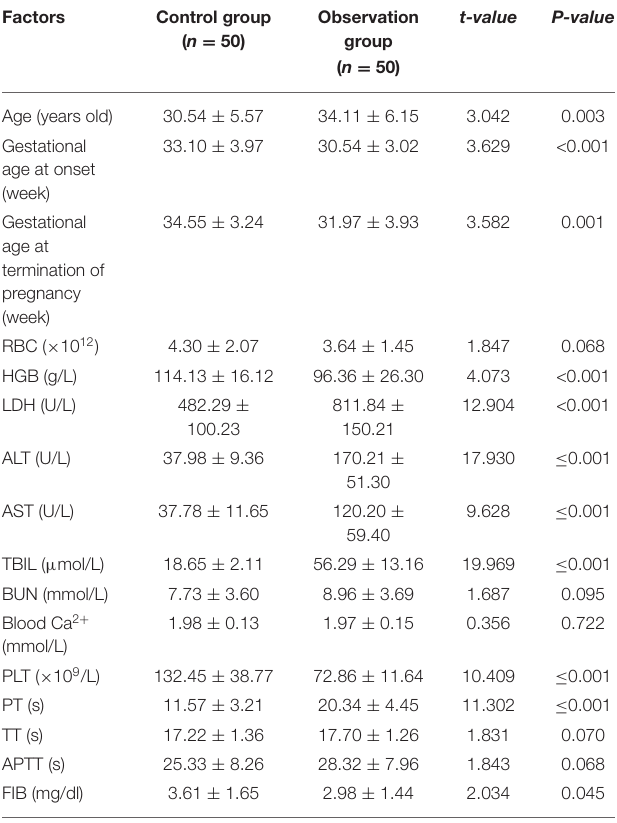
TABLE 3 | Results of univariate analysis of SPE complicated by HELLP syndrome ( n , M ± SD).